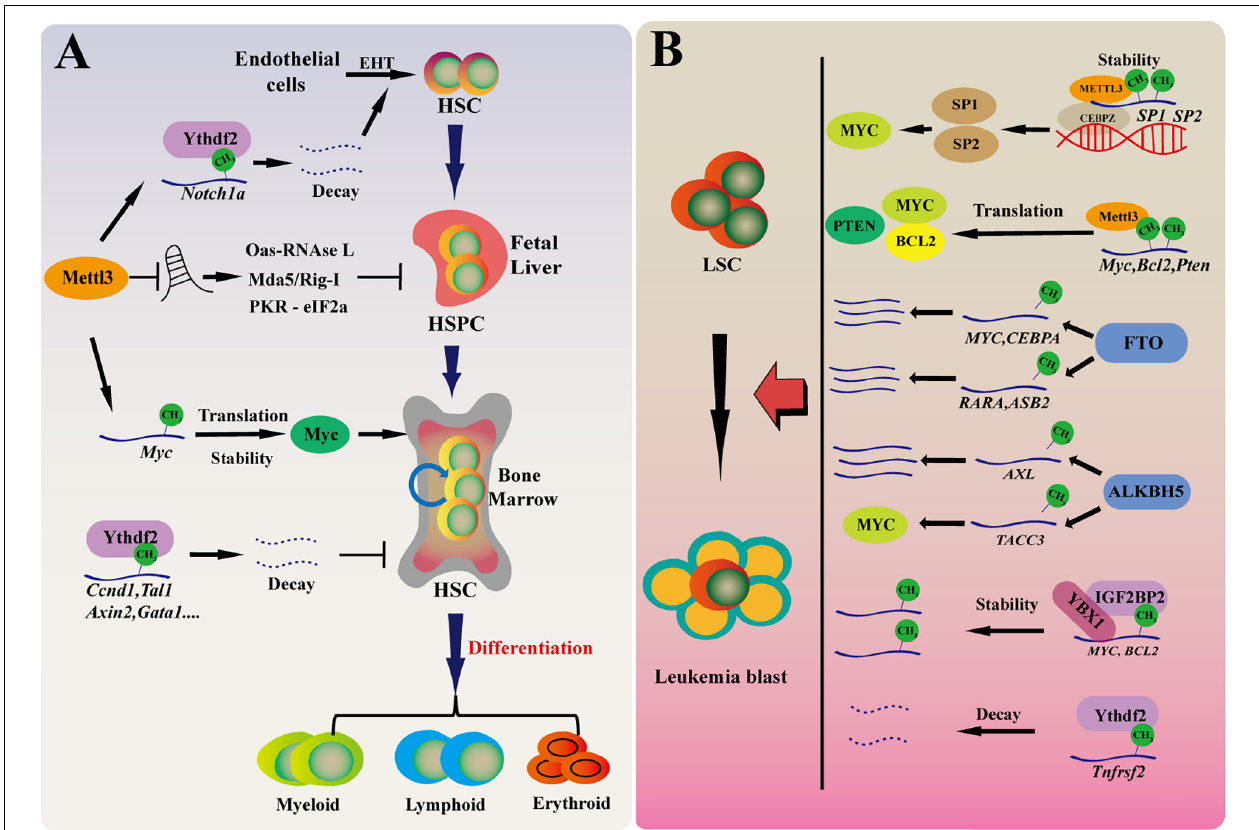
FIGURE 2 | RNA m 6 A in maintaining HSCs and LSCs function in normal and malignant hematopoiesis. (A) m 6 A modification regulates normal hematopoietic system. Mettl3 mediated m 6 A modification regulates HSPC fate specification by inhibiting Notch signaling during early definitive hematopoiesis. During HSPC expansion in fetal liver, Mettl3 deletion promotes dsRNA formation, activates OAS RNase L and PKR-eIF2a pathways, and upregulates MDA5/RIG-I, leading to hematopoietic failure. In adult HSCs, Mettl3 regulates the translation of c-Myc and promotes the proliferation of hematopoietic stem cells. Ythdf2-deficient HSCs display chronic activation of inflammatory pathways, resulting in a progressive myeloid bias. EHT, endothelial-to-hematopoietic transition. (B) The role of RNA m 6 A for LSCs in myeloid leukemia. The m 6 A level of cancer-related genes are affected with m 6 A “writer,” “reader,” and “eraser” by regulating mRNA translation, decay, stability in the development of AML. These cancer-related genes promote the development of leukemia by affecting proliferation, differentiation, cancer self-renewal, and